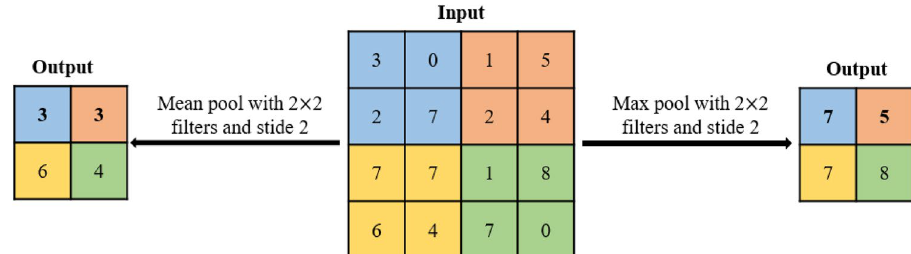
Fig. 3 Examples of pooling